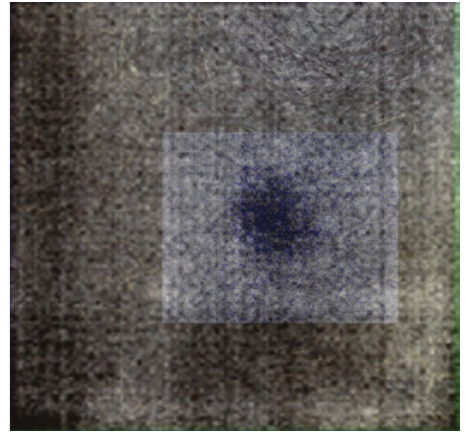
Figure 9 Fusion of images: 4B, 8A and E.